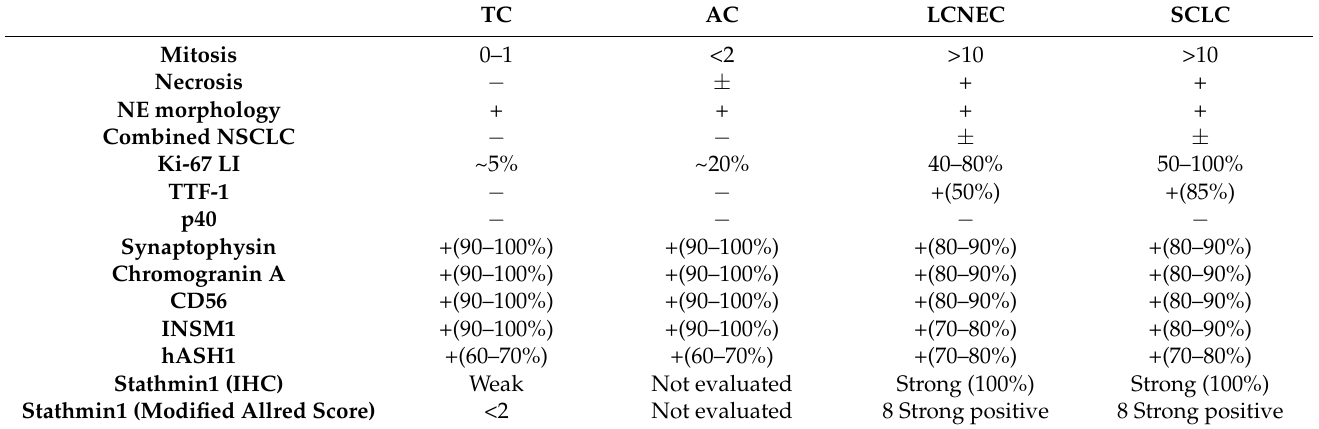
Table 1. The characteristics of each diagnostic method of neuroendocrine